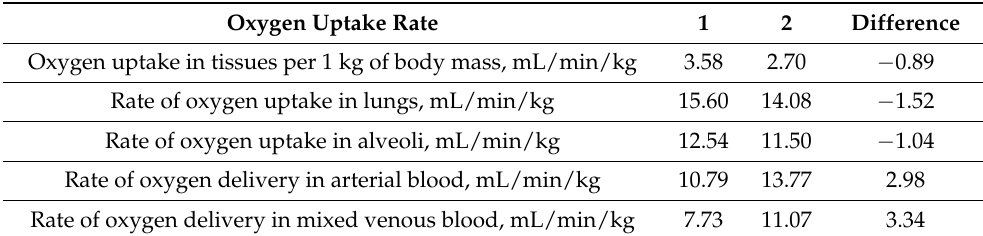
Table 4. Indicators of oxygen uptake rate per 1 kg of body mass at all stages of oxygen supply in the same person at normal body weight (1) and overweight (2). Oxygen Uptake Rate 1 2 Difference Oxygen uptake in tissues per 1 kg of body mass,